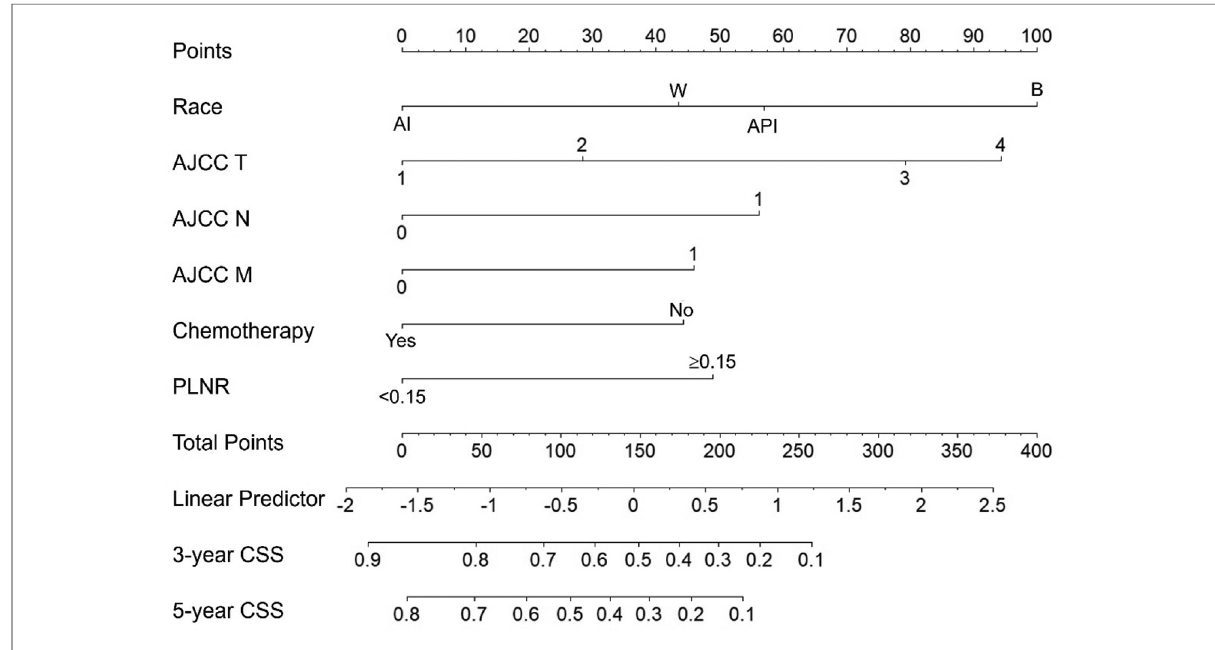
FIGURE 3 The nomogram predicting 3- and 5- years CSS in patients with ICC after hepatectomy.